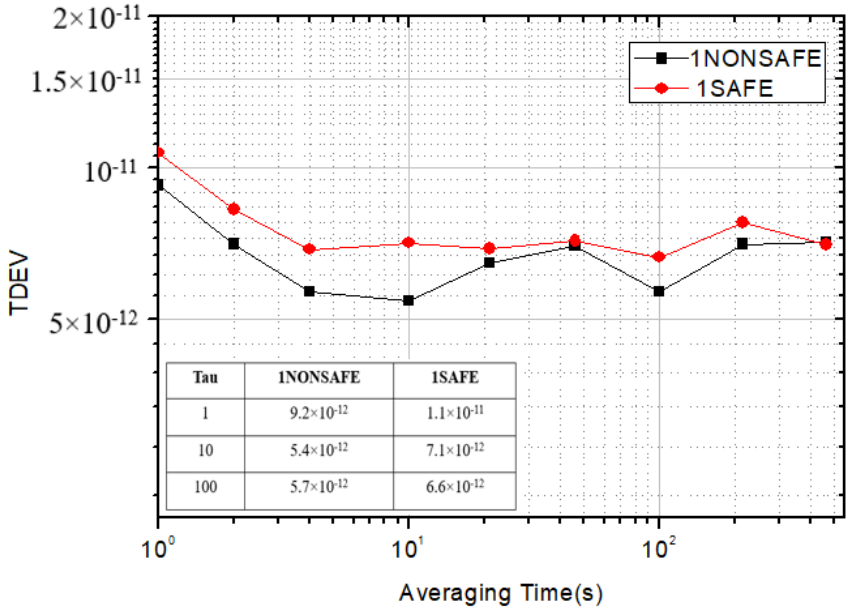
Figure 7. TDEV comparison chart of single equipment.